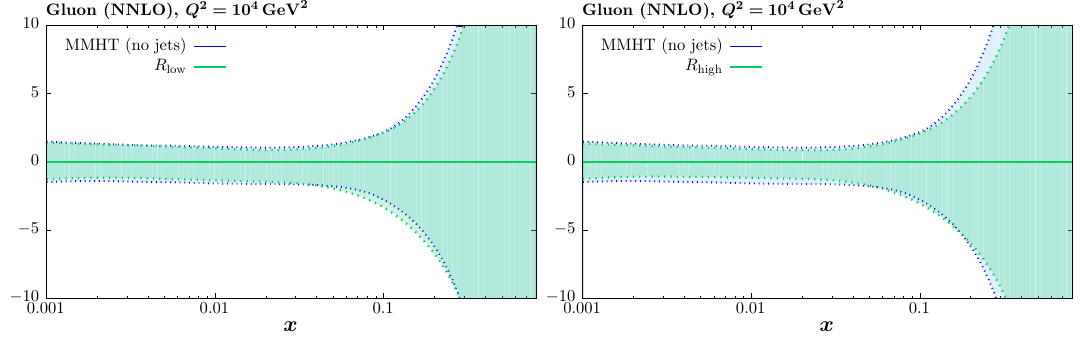
Fig. 11 The impact on the gluon PDF when fitting the ATLAS [23] and CMS [24] 7 TeV jet data and Tevatron data [14,15] individually, as well as including all data sets within the fit. For the LHC case R high and p jet ⊥ are taken. The NLO (NNLO) results are shown in the left (right) plots